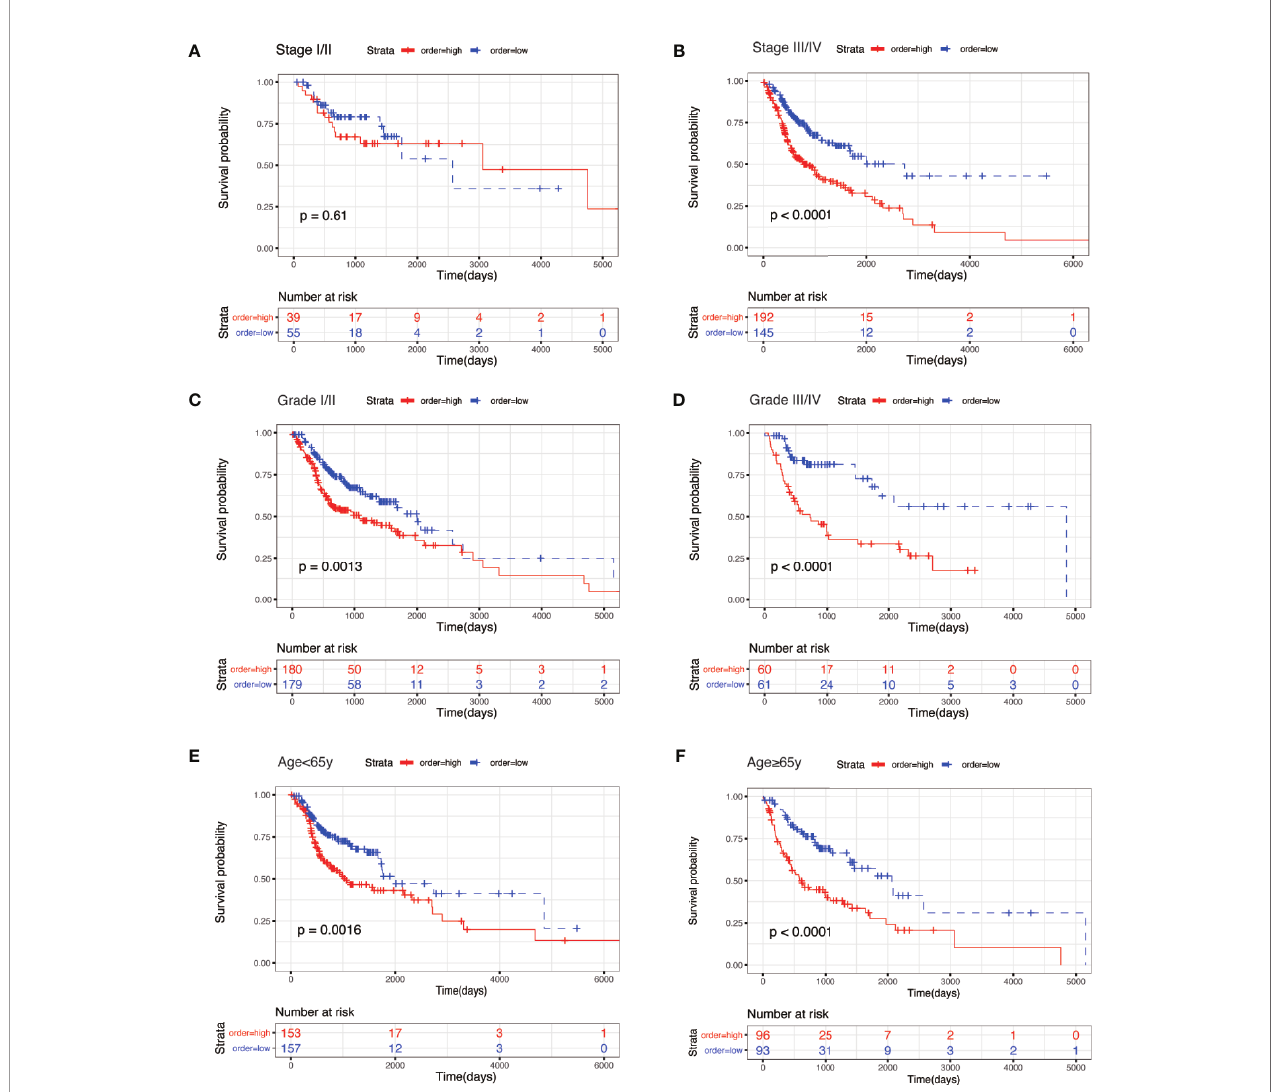
FIGURE 5 | KM survival subgroup analysis for all patients with HNSC according to the eight-gene signature strati fi ed by clinical characteristics. (A) Stage I/II. (B) Stage III/IV. (C) Grade I/II. (D) Grade III/IV. (E) age <65 year. (F) age ≥ 65